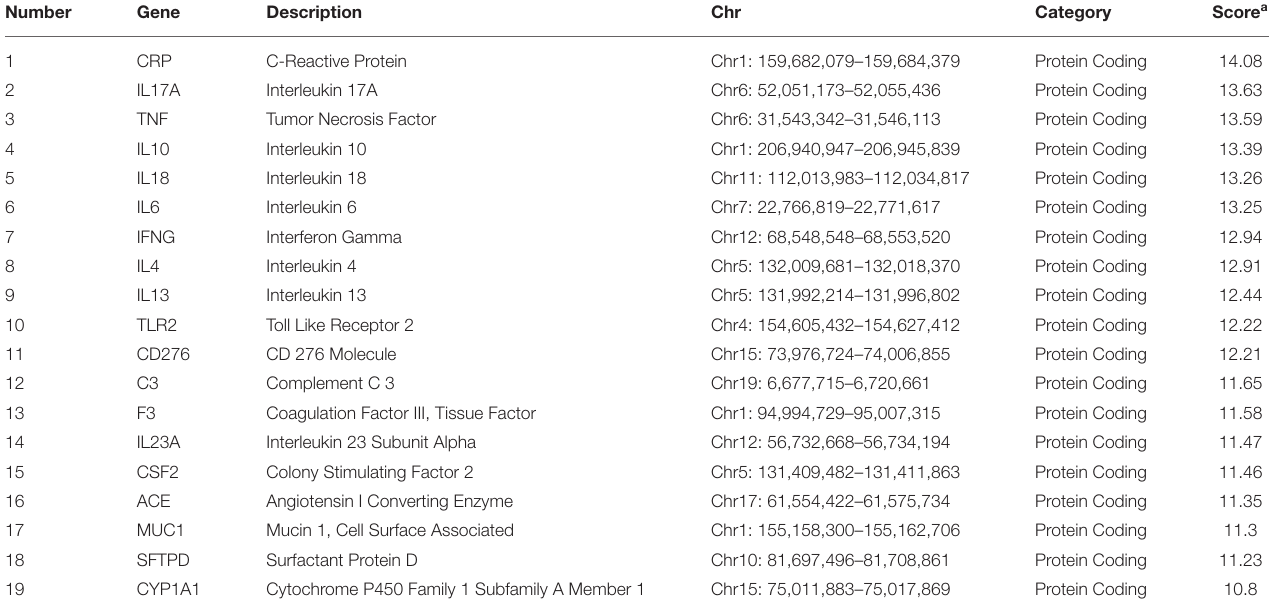
TABLE 2 | 19 genes related to MPP.